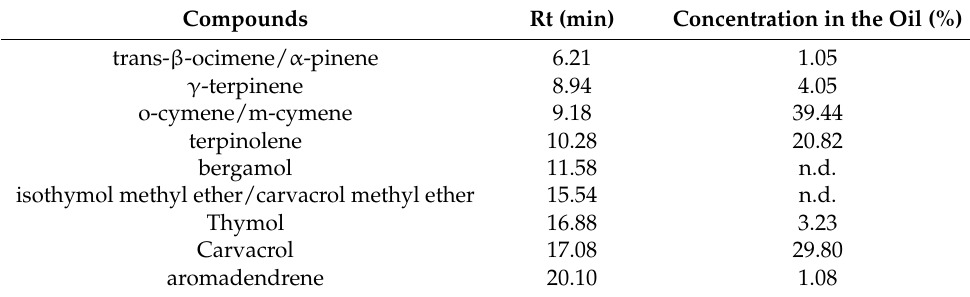
Table 1. GC–MS data of the oregano oil. Compounds Rt (min) Concentration in the Oil (%) trans- β -ocimene/ α